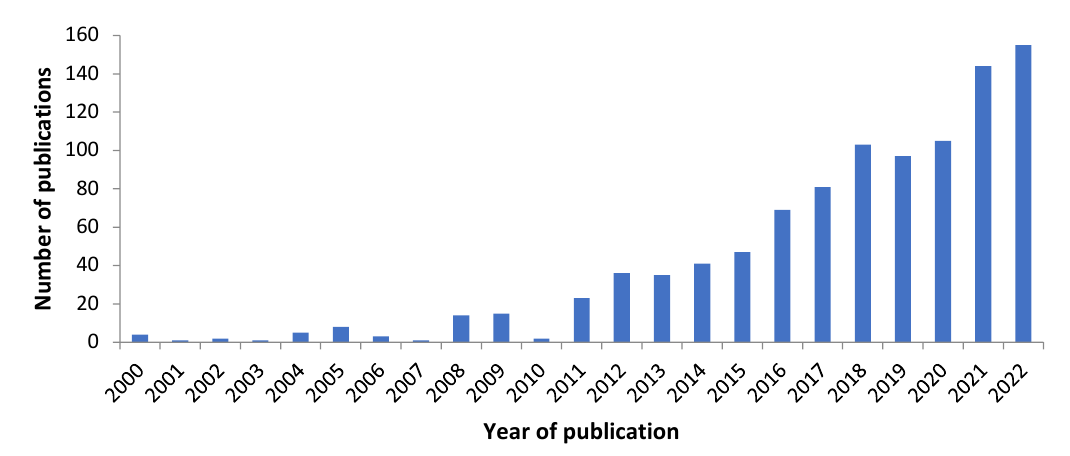
Figure 1. The number of journal articles published between 2000 and 2022 containing the phrase “plant endophyte compounds” and “plant endophyte metabolites” within the title, abstract, or as a keyword (data based on a search from PubMed, January 14, 2023).